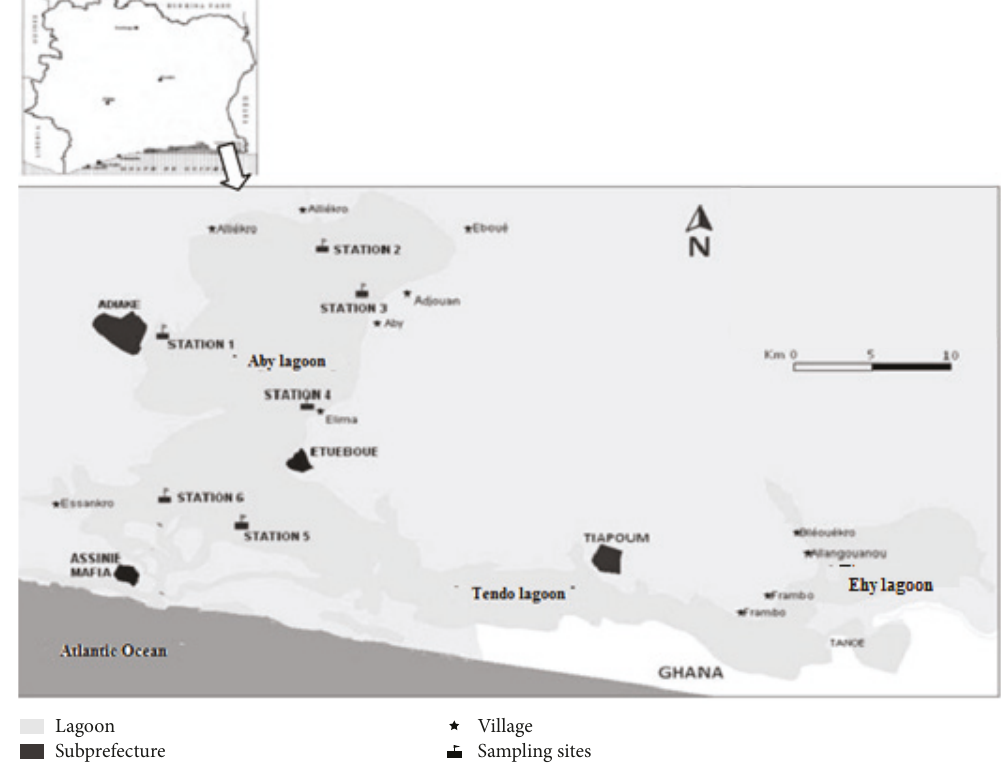
Figure 1: Study area and sampling stations